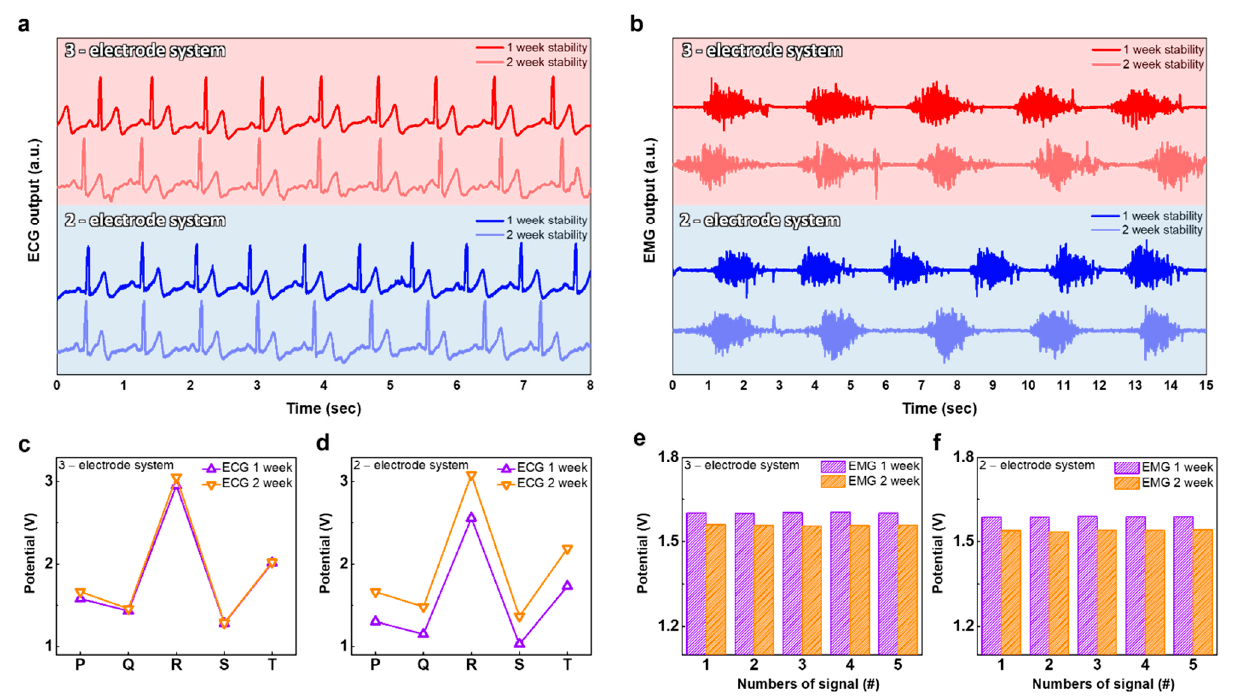
Figure 7. The robustness of the WPD electrodes. ( a ) Repeatability tests for 2 weeks with the WPD electrode for ECG biopotential signals; ( b ) repeatability tests for 2 weeks with the WPD electrode for EMG biopotential signals; the biopotential signal detected for 2 weeks at intervals of 1 week; ( c ) the PQRST peak in 3-electrode system; ( d ) the PQRST peak in 2-electrode system; ( e ) the quantified EMG biopotential signals in 3-electrode system; ( f ) the quantified EMG biopotential signals in 2-electrode system.